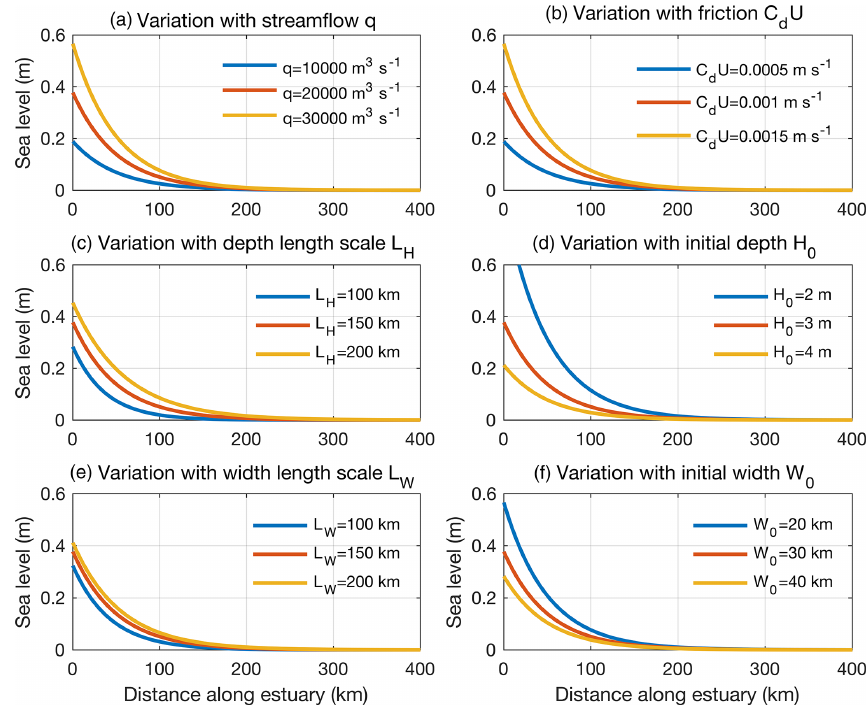
Figure 10. Sea-level response (cid:104) ζ (cid:105) to streamflow forcing q described by Eq. (12) as a function of distance along the estuary away from the mouth of the rivers for different values of (a) streamflow q , (b) friction C d U , (c) depth length scale L H , (d) initial depth H 0 , (e) width length scale L W , and (f) initial width W 0 . Default values are q = 2 × 10 4 m 3 s − 1 , C d U = 0 . 001ms − 1 , L H = 150km, H 0 = 2m, L W = 150km, and W 0 =